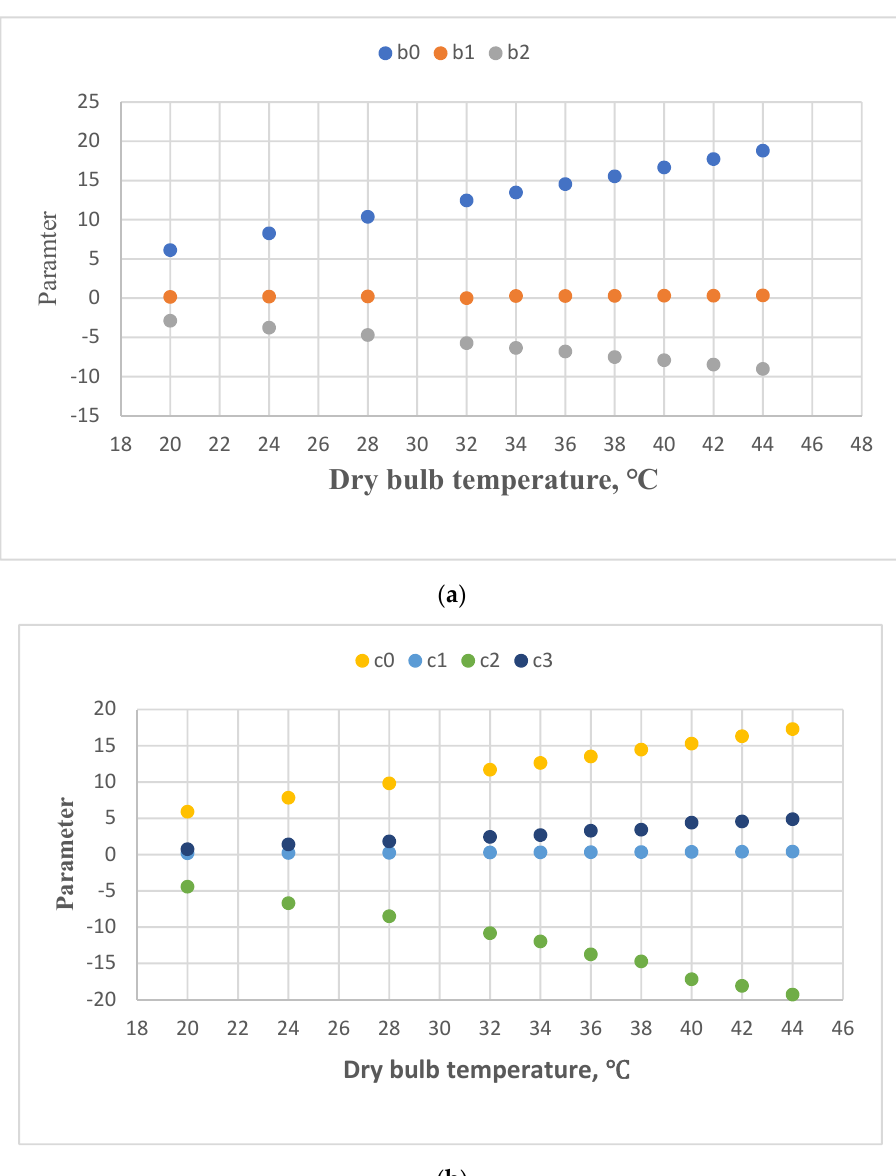
Figure 2. The relationship between the parameters for Equations (2) and (3) and the dry-bulb temperature. ( a ) b 0 , b 1 , and b 2 parameters, ( b ) c 0 , c 1 , c 2 and c 3 parameters. Considering the effect of Td values on the parameters for Equations (2) and (3), Equa- To determine the degree of fitting between the Tw equations, the predicted Tw values tions (2) and (3) are modified as: by regression equation and the standard Tw values that are calculated using the psychro- metric principle are compared. The difference between the predicted value by the model and the standard value is called the error. The criteria for comparison are the maximum error, e max , the minimum error, e min , the average sum of absolute errors, | e | ave , and the standard deviation for errors, e sd To determine the fitting-ability between Td and RH data and the Tw values, two empirical equations are established using regression analysis. The Td ranges from 20 °C to 45 °C and RH ranges from 40% to 99%. Model I: